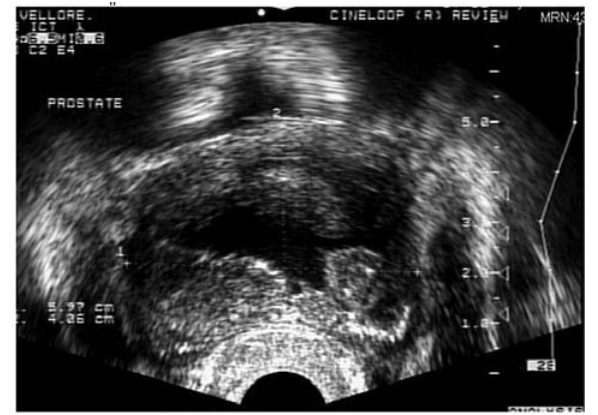
Figure 1 – Transrectal ultrasound showing prostatic abscess.